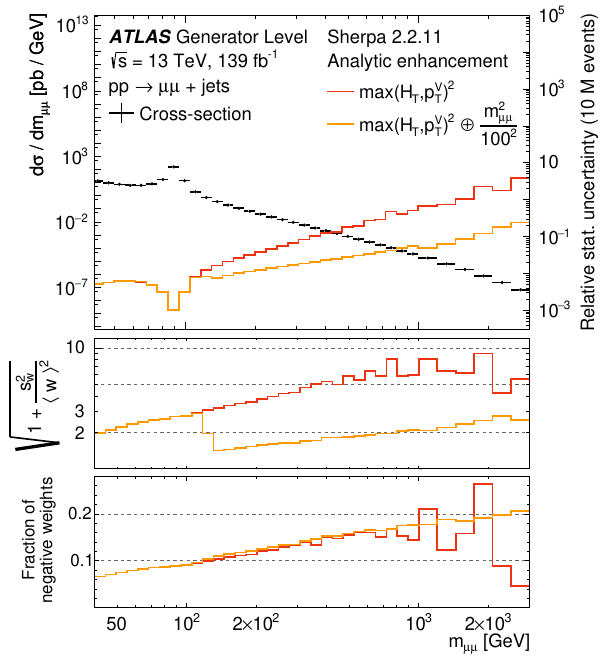
in black, as read µµ ) analytic enhancement , p V T T + max ( H ) analytic enhancement Sherpa 2.2.11 con- , p V µµ T T µµ